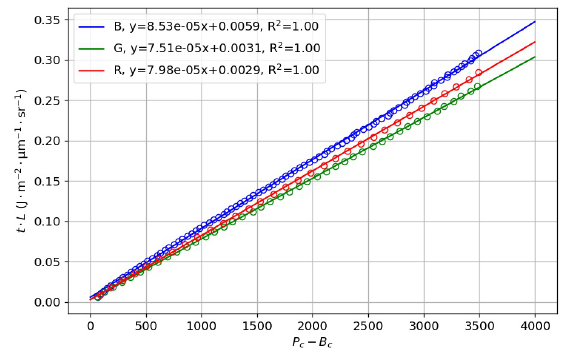
Figure 11. The regression curve for determining factor D of blue, green, and red band.